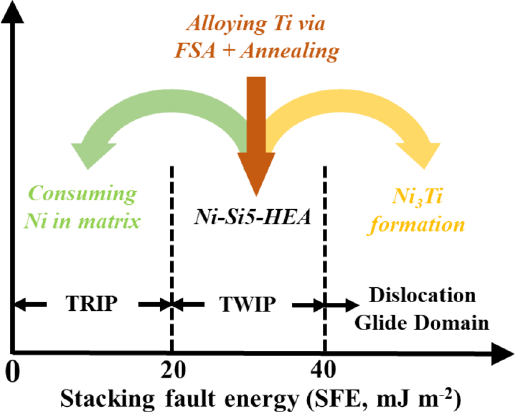
Figure 5. Schematic showing the proposed tuning pathway via